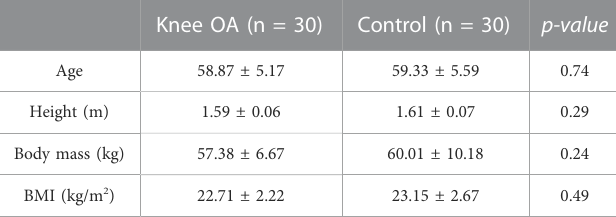
TABLE 2 Characteristics of the knee osteoarthritis (OA) and control groups.